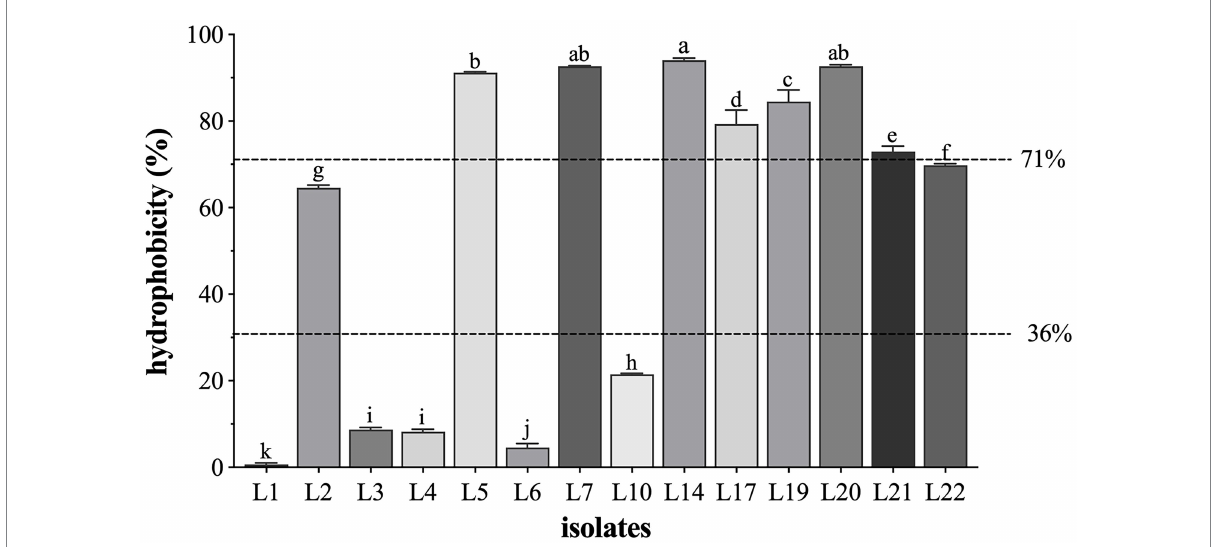
FIGURE 3 The cell surface hydrophobicity of 14 LAB isolates. Results are expressed as mean ± SD of triplicate tests. a-k Values in a column with different superscript letters are significantly different (Waller-Duncan, p < 0.05). The dotted lines represent the threshold to distinguish the surface hydrophobicity (high, medium, and low) of the tested